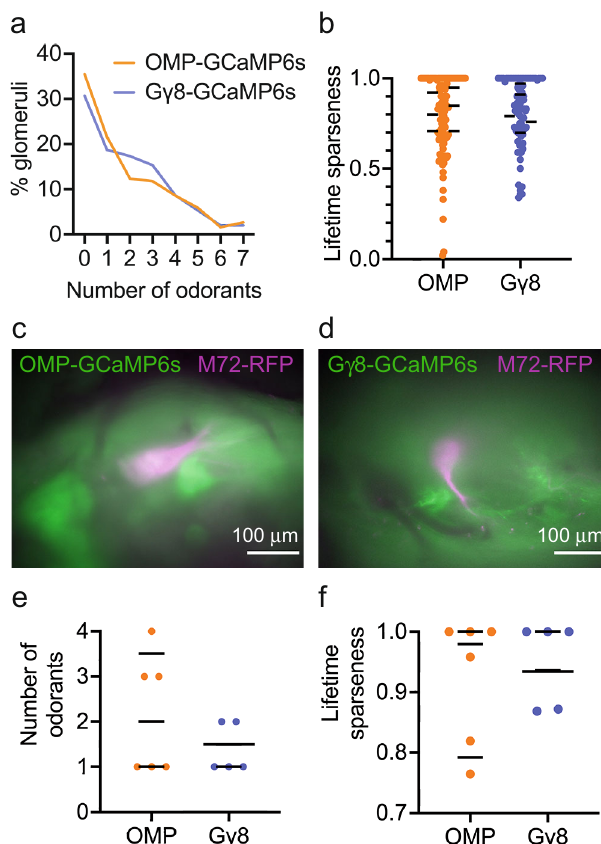
Fig.5|ImmatureandmatureOSNaxonsinnervatingtheM72glomerulusshow similarodorantselectivity.a GlomeruliinOMP-GCaMP6sandG γ 8-GCaMP6smice respondtoasimilarnumberofodorantsinaseven-odorantpanel(Wilcoxonsigned rank test. P =0.95, W = − 2, n =186 glomeruli in 6 OMP-GCaMP6s mice and 150 glomeruli in 6G γ 8-GCaMP6s mice). b Similar lifetime sparseness of glomerular odorant responses in OMP-GCaMP6s and G γ 8-GCaMP6s mice (Nested t -test. P =0.97, t =0.037. n =120 responding glomeruli in 6 OMP-GCaMP6s mice and 97 respondingglomeruliin6G γ 8-GCaMP6smice).Lines:meanvaluesforeachmouse, symbols:individualglomeruli. c CameraimageshowingM72glomerulus(magenta) andbaselineGCaMP6s fl uorescence(green)inmatureOSNaxonsinvivothrougha cranial window. d Camera image showing M72 glomerulus (magenta) and baseline GCaMP6s fl uorescence (green) in immature OSN axons in vivo through a cranial window. e Mature and immature OSN axons in lateral M72 glomeruli respond to a similar number of odorants (Nested t -test. P =0.36, t =1.03, n =6 glomeruli from 3 OMP-GCaMP6s-M72-RFP mice and 5 glomeruli from 3G γ 8-GCaMP6s-M72-RFP mice). Lines: mean for each mouse, symbols: individual M72 glomeruli. f Lifetime sparsenessofodorantresponsesofmatureandimmatureOSNaxonsinlateralM72 glomeruli is similar (Nested t -test. P =0.70, t =0.42, n =6 glomeruli from 3 OMP- GCaMP6s-M72-RFP mice and 5 glomeruli from 3G γ 8-GCaMP6s-M72-RFP mice). Bars: mean for each mouse, symbols: individual M72 glomeruli. Long bar in G γ 8 group represents two mice. All statistical tests were two-tailed. Source data are provided as a Source Data fi le.